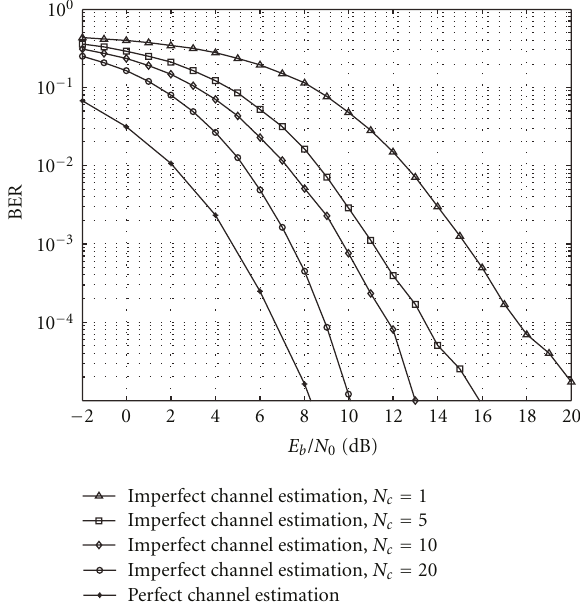
Figure 4: The impact of channel estimation on the proposed scheme. N t = 2, N r = 2, and T s =